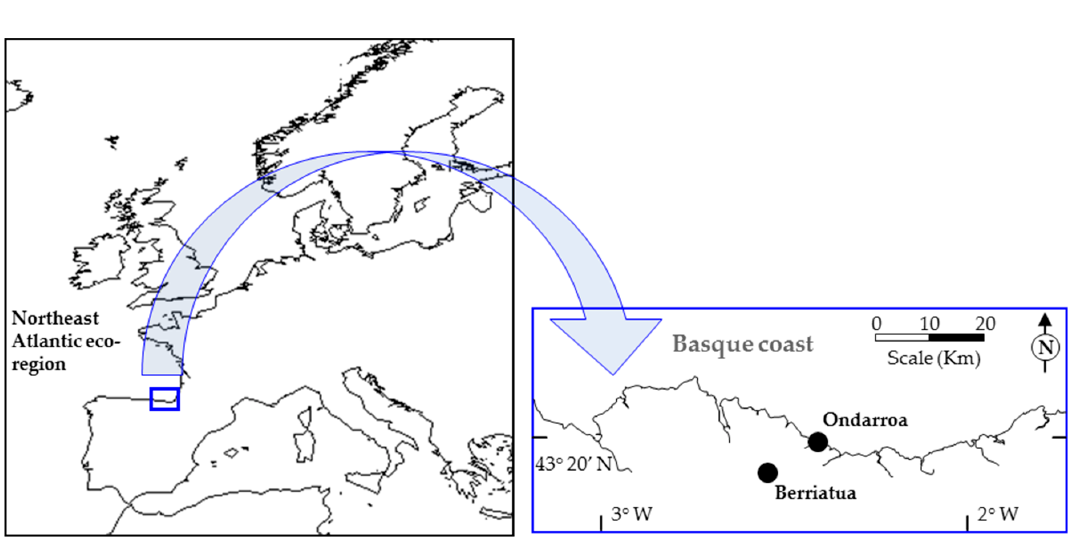
Figure 2. Project demonstration area .